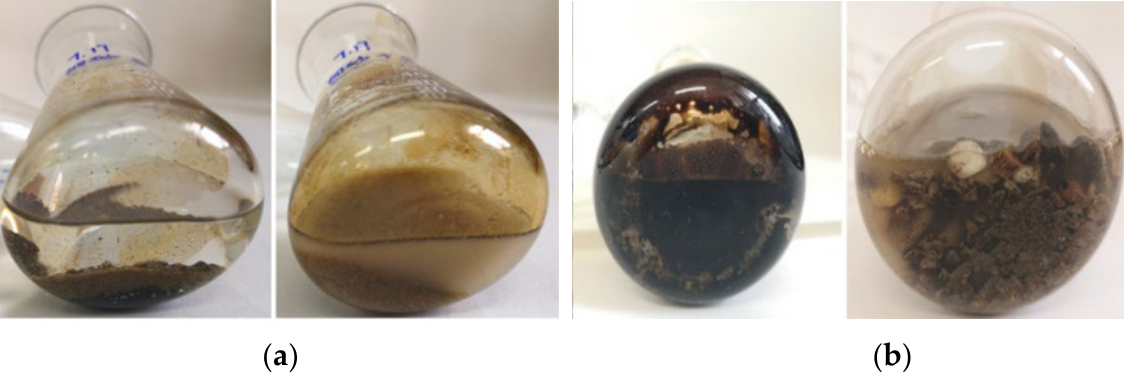
Figure 3. ( a ) Oil washing efficiency of sand with biosurfactant produced by Planococcus sp. XW-1. (1) The end of the sand washing, control group; (2) the end of the sand washing with 50 mL (60 mg/L)biosurfactant. ( b ) Oil washing efficiency of stone with biosurfactant produced by Planococcus sp. XW-1. (1) The end of the sand washing, control group; (2) the end of the sand washing with 50 mL (60 mg/L) biosurfactant.